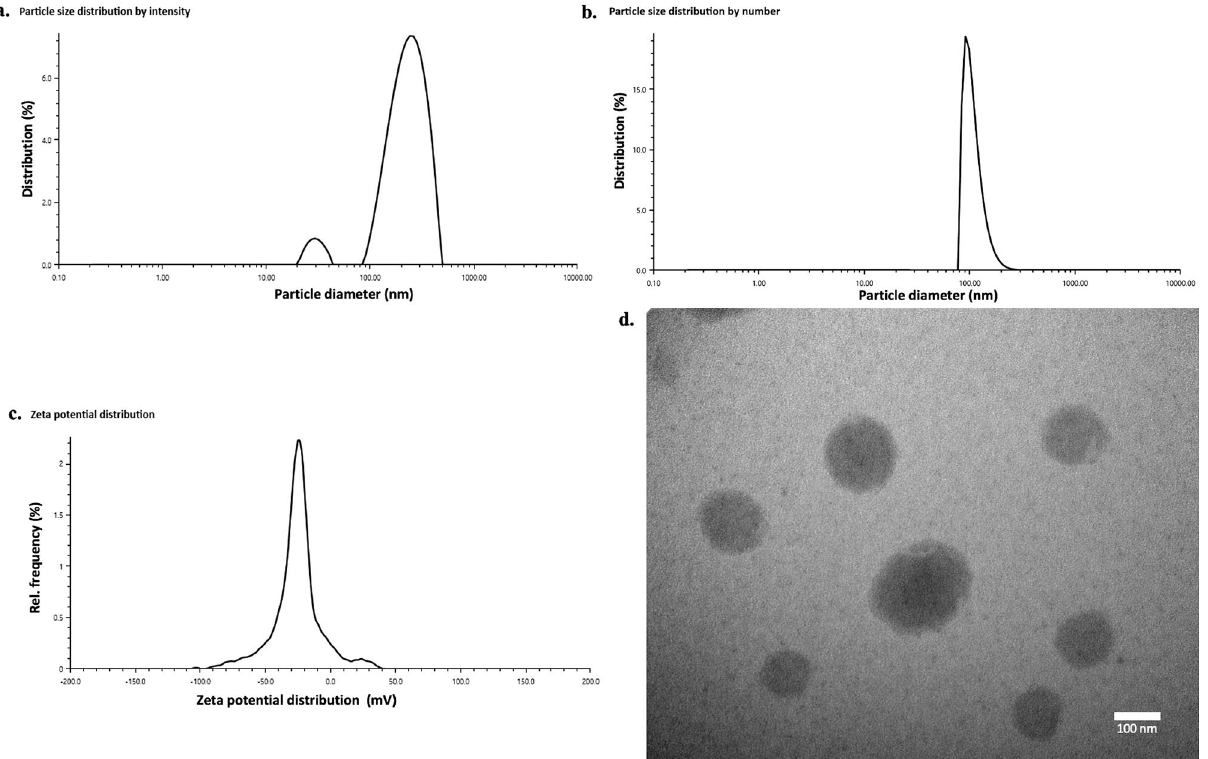
Figure 1. Optimal nanoemulsion characterization (particle size distribution; zeta potential distribution; and TEM images).